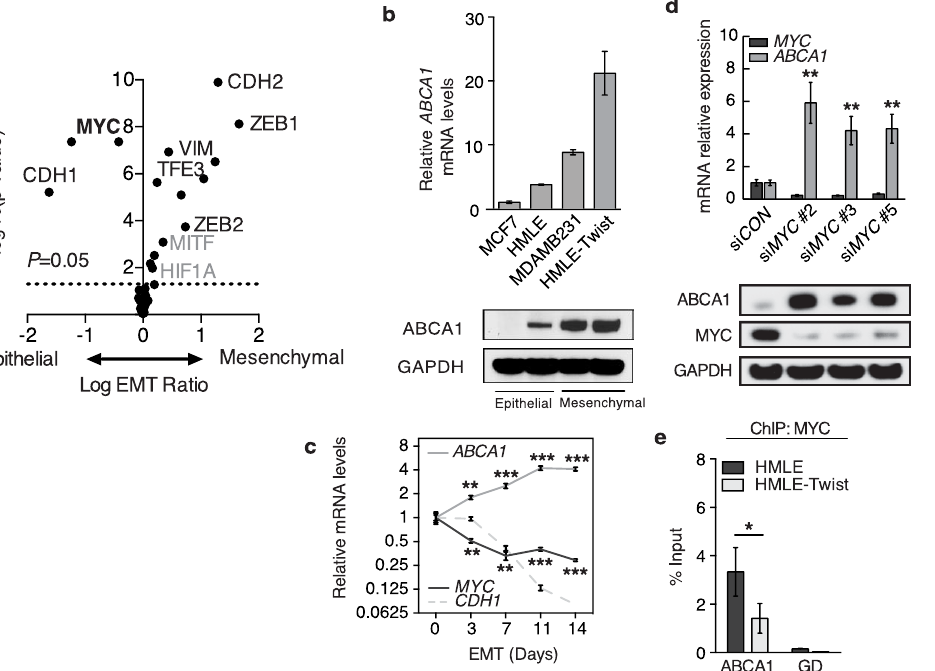
Figure 3. MYC binds to the ABCA1 promoter and represses its expression in epithelial cells. ( a ) This volcano plot shows the relative log 2 expression of E-box binding transcription factors on the x -axis. Each transcription factor is shown as a dot, and those expressed higher in mesenchymal cells are shown on the right, while those expressed higher in epithelial cells are on the left. The y -axis shows the − log 10 of the p -value. A dotted line indicates p = 0.05. ( b ) The gene ( top ) and protein ( bottom ) expressions of ABCA1 are shown for four cell lines ( n = 3 technical replicates). Error bars indicate one standard deviation. Statistical significance is indicated as in Figure 1. ( c ) The relative gene expressions of ABCA1 , MYC , or CDH1 are shown on the y -axis across time ( x -axis) in log scale ( n = 3 technical replicates). Error bars indicate one standard deviation. ( d ) ( top panel ) The relative gene expressions of ABCA1 or MYC in HMLE cells are shown on the y -axis after knockdown with three independent siRNAs targeting MYC ( n = 3 technical replicates). Error bars indicate one standard deviation. ( bottom ) These immunoblots show the protein expression in the same conditions. ( e ) The binding affinity of MYC to the ABCA1 promoter or a gene desert ( GD ) region is quantified relative to input ( y -axis) ( n = 3 technical replicates). Error bars indicate one standard deviation. At least three biological replicates were performed for experiments shown in panels b, d, and e, and representative data are shown. The data in panel ( a ) were aggregated from six data sets. For panel ( c ), the time series has been measured over five times, but the time points profiled in the middle samples varied. * p < 0.05, ** p < 0.01, *** p <